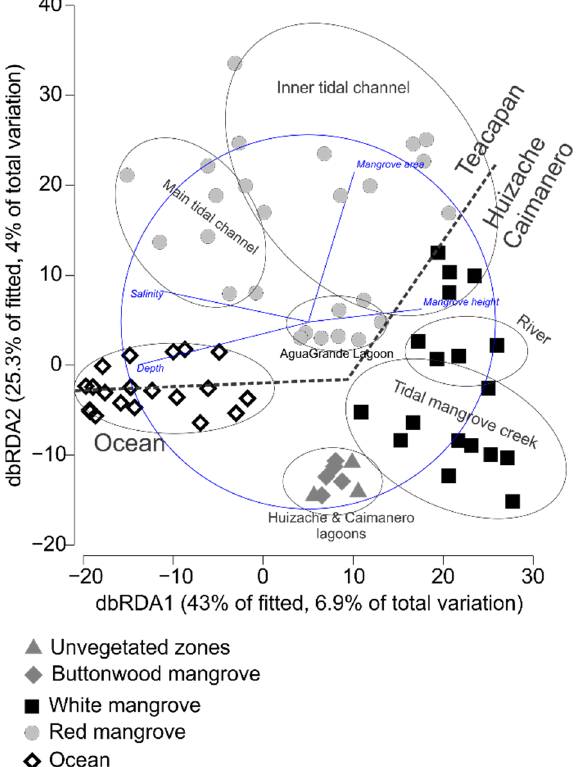
Figure 4. Distance-based redundancy analysis plot based on the results of the distance-based linear model permutation test (DISTLM) describes the aggrupation of zones based on the fish assemblages’ composition and displays the environmental variables that had significant effect on for each group. Table 2. Marginal test of the distance-based linear model (DISTLM) showing the relationships of the different environmental factors with the fish assemblages. * indicates statistically significant re- sults.